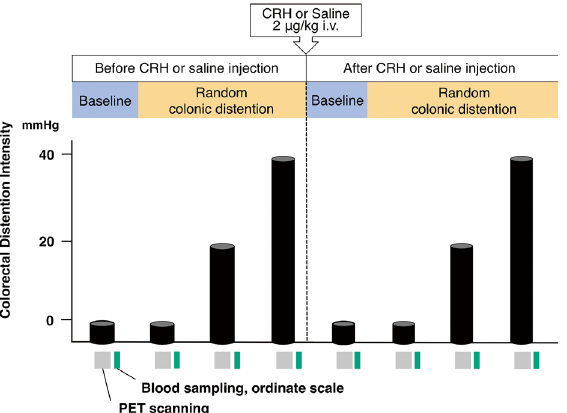
Fig 1. Scanning and distention protocol. A barostat bag was inserted into the colorectum and was inflated with baseline (0 mmHg), no distention (0 mmHg), mild (20mmHg), or intense (40 mmHg) distention for 80s. The time interval between two stimuli was 15 min to allow for radiotracer decay. Conditions were in random order, but baseline was always first. CRH (2 μ g/kg) or placebo was then injected and same distention protocol was repeated. Radioactive H 2 [ 15 O] was injected at bag inflation and then the PET scan was acquired. Blood sampling and ordinate scales for subjective symptoms were measured immediately after each stimulation. Column: baseline, no distention, 20 mmHg or 40 mmHg